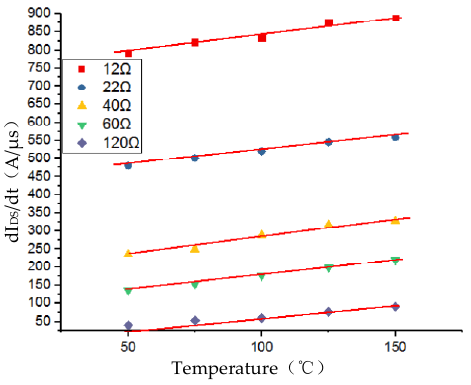
Figure 12. The dI DS /dt under different resistances and temperatures.